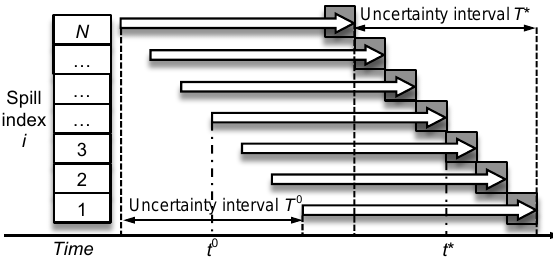
Figure 4. Uncertainty Scenario III with respect to the initial and final dates of the oil spill.